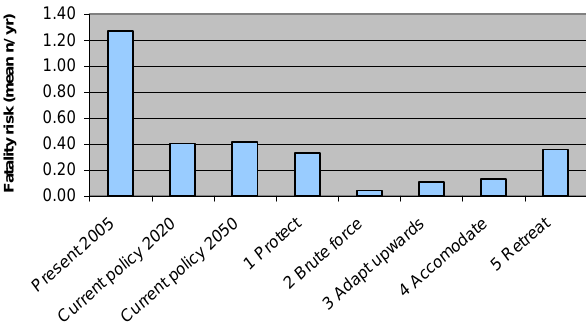
Figure 4. Fatality risk (mean annual number of fatalities) in the various strategic alternatives in 2050, in comparison to the development of the risk between 2005 and 2050 assuming continuation of the current policy.